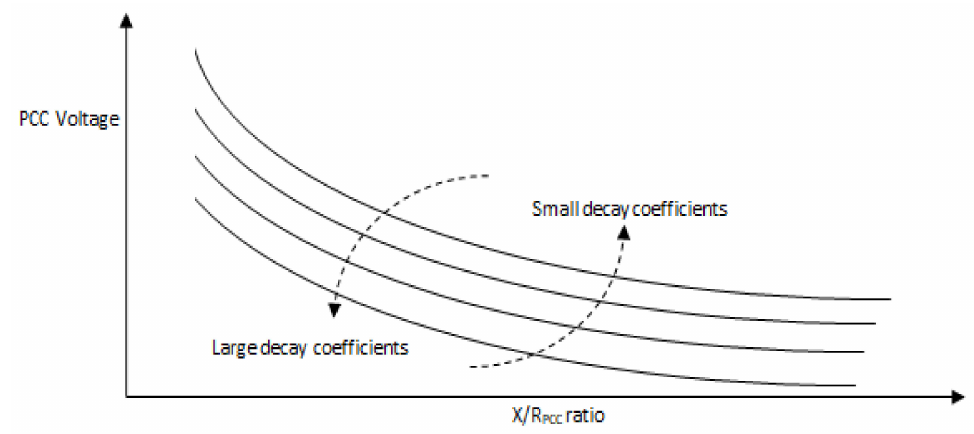
Figure 4. General V PCC -X / R PCC characteristic curve given by (3) and (4) for di ff erent decay coe ffi